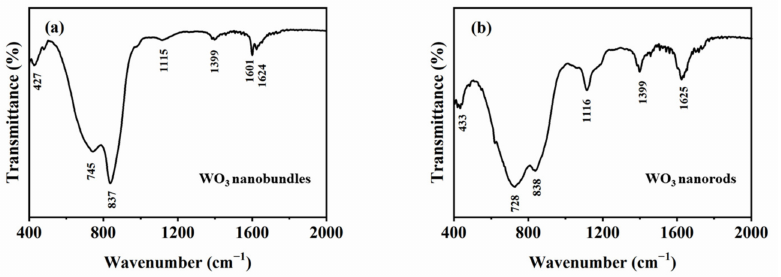
Figure 6. FT-IR spectra of the formed WO 3 with different shapes. ( a ) WO 3 nanobundles, ( b ) WO 3